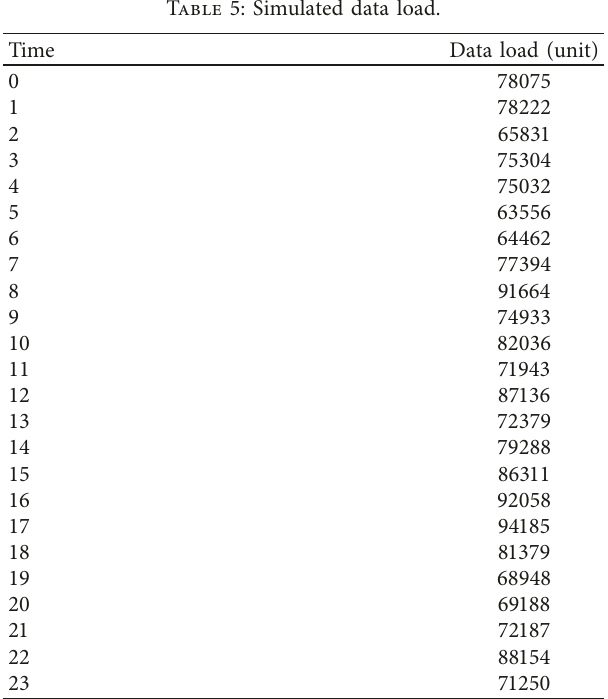
Table 5: Simulated data